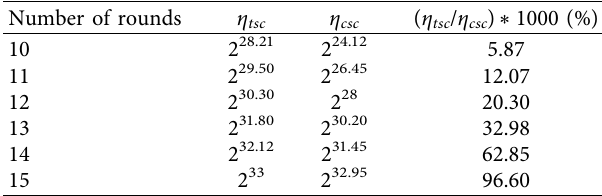
Table 2: Statistical results for the successful attacks based on the experimental analysis ( η tsc : mean of total state candidates; η csc : mean of complete state